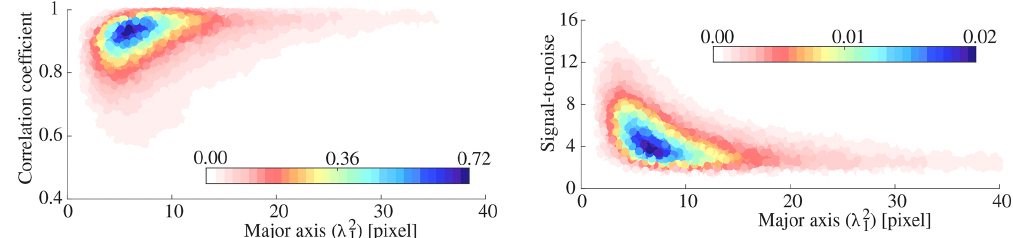
Figure 11. Probability scatterplots between different matching descriptors for the Malaspina Glacier system.